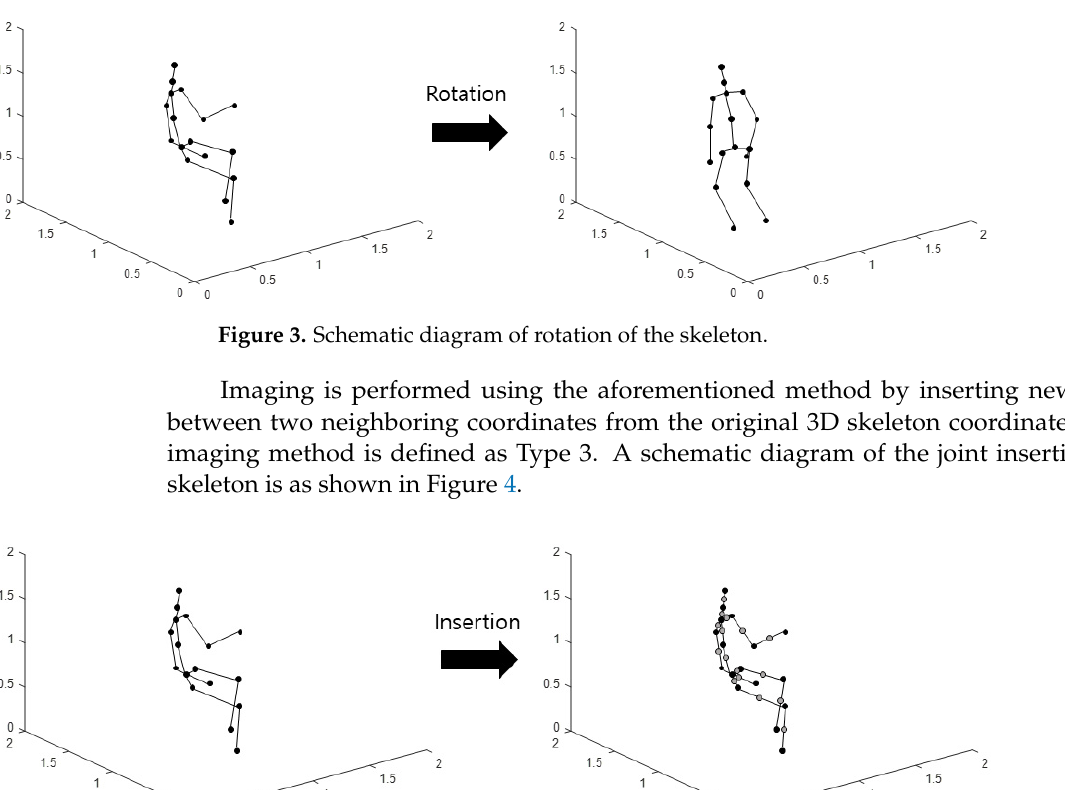
Figure 2. Comparison of feature extraction before and after pose evolution image (PEI) conversion.